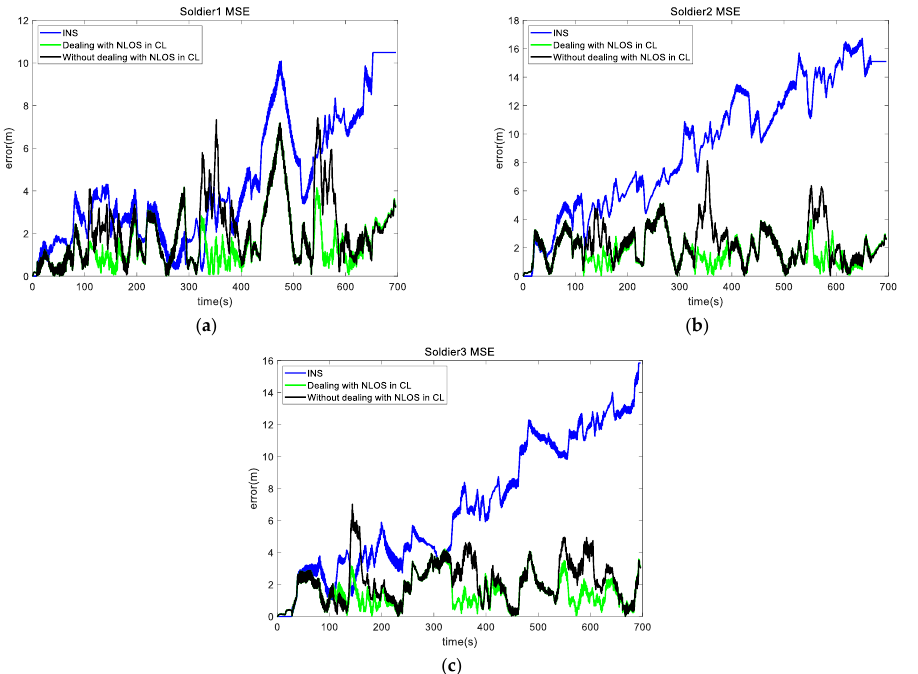
Figure 9. MSE of soldiers in the forest environment experiment. ( a ) MSE of soldier 1; ( b ) MSE of soldier 2; ( c ) MSE of soldier 3.